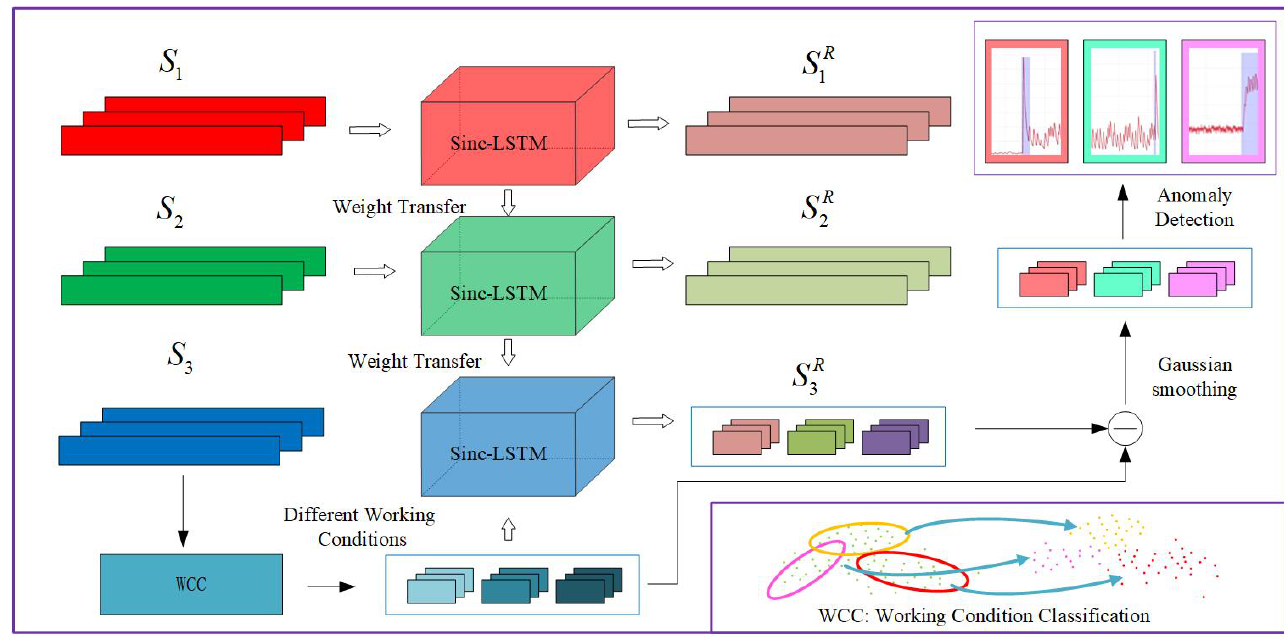
Figure 1. The overall flowchart of proposed anomaly detection based on domain adaptive LSTM and working condition